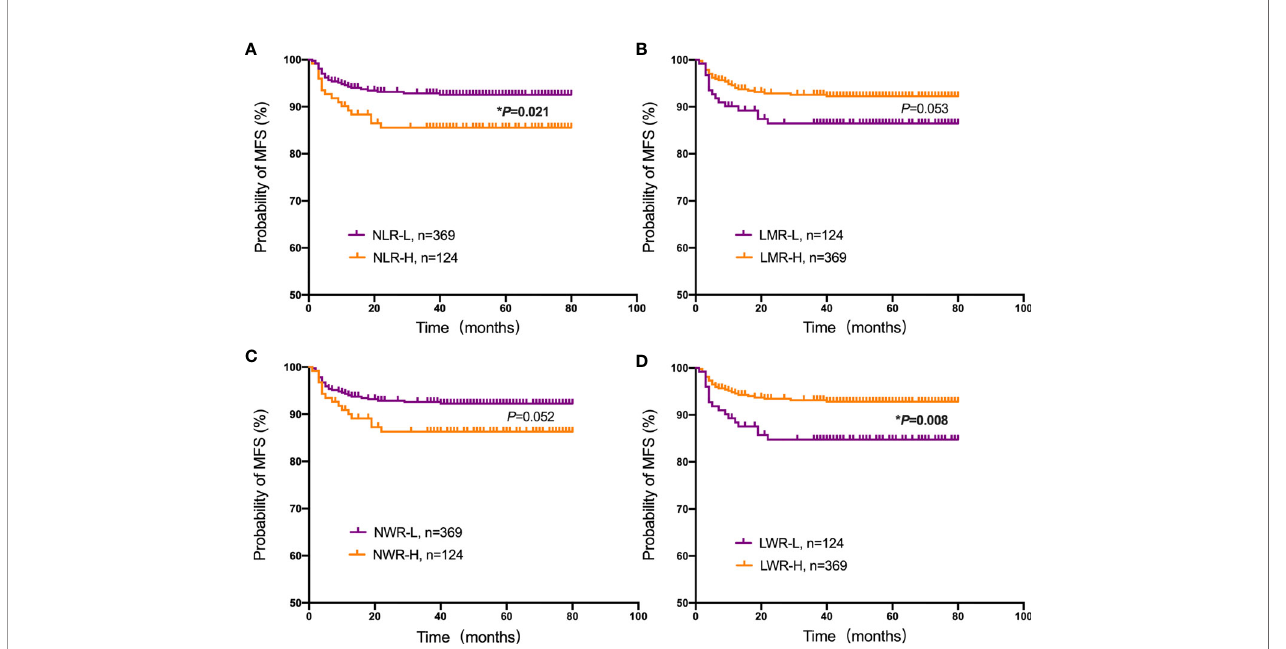
FIGURE 4 | Kaplan-Meier plots for the probability of metastasis-free survival (MFS). MFS rates of the patient subgroups strati fi ed by the (A) neutrophil-to-lymphocyte ratio (NLR), (B) lymphocyte-to-monocyte ratio (LMR), (C) neutrophil-to-white blood cell ratio (NWR) and (D) lymphocyte-to-white blood cell ratio (LWR). Asterisks (*) indicate statistical signi fi cance.